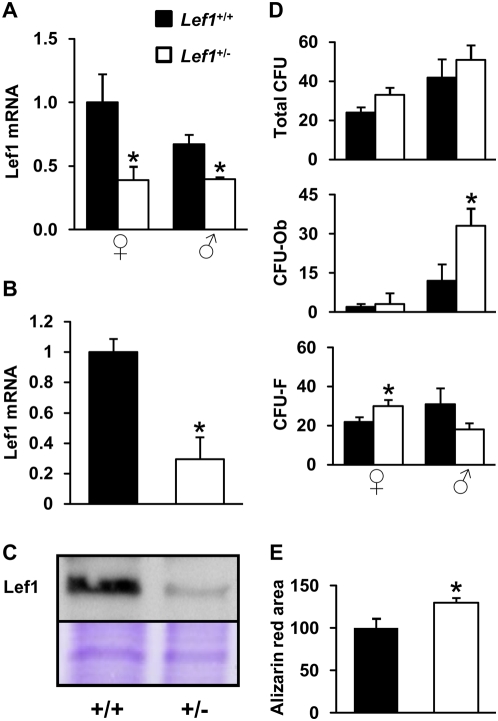
Reduced Lef1 expression is not associated with impaired osteoblast differentiation in vitro.(A,B) Lef1 mRNA in tibia of Lef1
+/− and control male and female mice (A) and in NeMCO cultures (B) was assessed by RT-qPCR and corrected for the expression of GAPDH and rpL10A, respectively. Bars represent relative expression levels (Mean±SEM, n = 3). (C) Western blot analysis of Lef1 expression in NeMCO cultures. Equal loading was demonstrated by Coomassie blue staining (bottom panel shows a ∼60 KDa Coomassie blue-stained band). (D) Bone marrow mesenchymal cells from WT and Lef1+/− mice of each gender were cultured for 28 days, fixed and stained with Alizarin red. Colonies were manually counted in each of 6–11 independent cultures for each condition. Alizarin red-positive colonies were counted as osteoblastic colony-forming units (CFU-Ob), and the rest were considered fibroblastic CFU (CFU-F). (E) Day-20 NeMCO cultures from WT and Lef1+/− mice were fixed and stained with Alizarin red. Data represent mean mineralized area relative to WT±SEM in at least 3 cultures per condition. * = p<0.05 vs. WT.